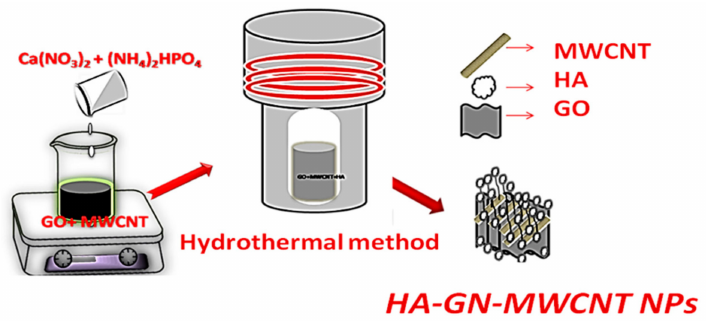
Figure 1. Representation of the procedure adopted for the synthesis of HA-GN-MWCNT